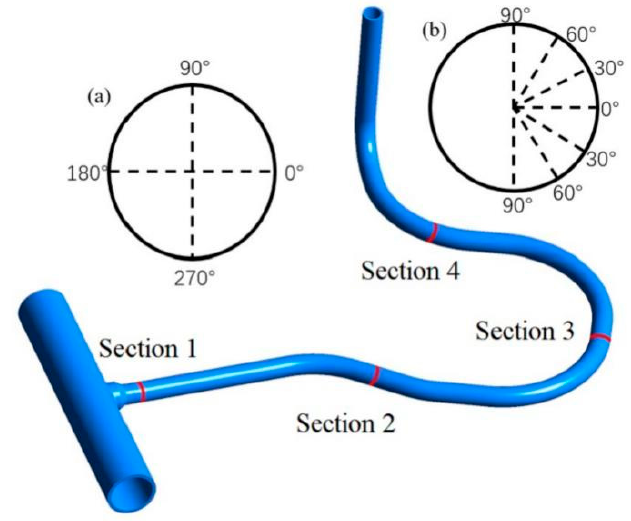
Figure 18. Position of the monitoring points. ( a ) Section 1. ( b ) Sections